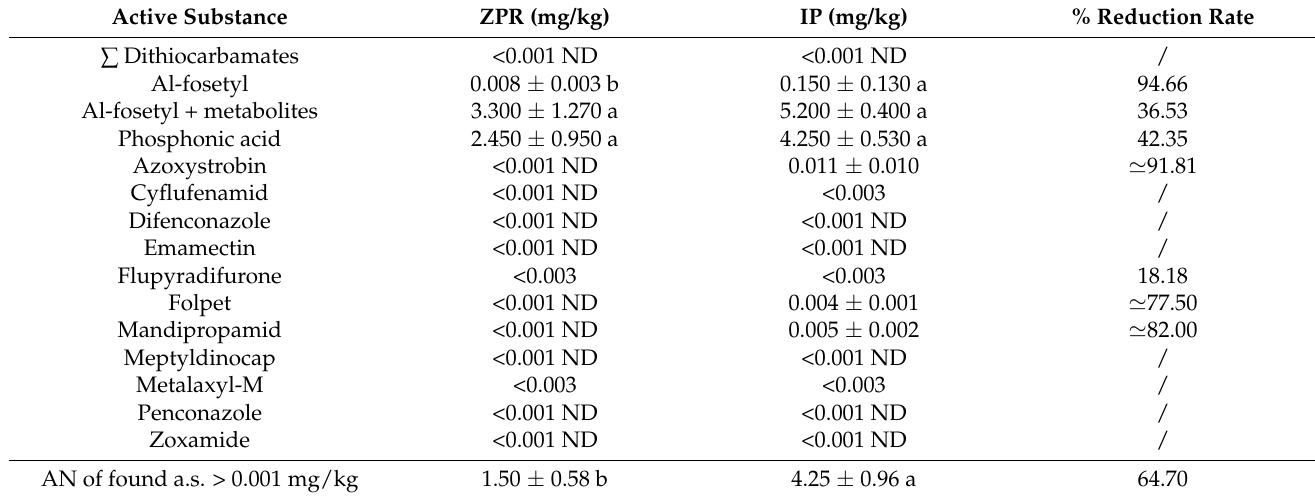
Table 12. Average concentration (mean ± SE) of pesticide residues in Rebula wine. A result of <0.001 ND means that a.s. was not detected at a level higher than 0.001 mg kg − 1 . /—concentration reduction rate and significance of difference between IP (integrated) and ZPR (0-pesticide residue) means cannot be calculated. Pesticide concentration reduction rate (%) = 100 − ((ZPR/IP) × 100) (see explanation in Section